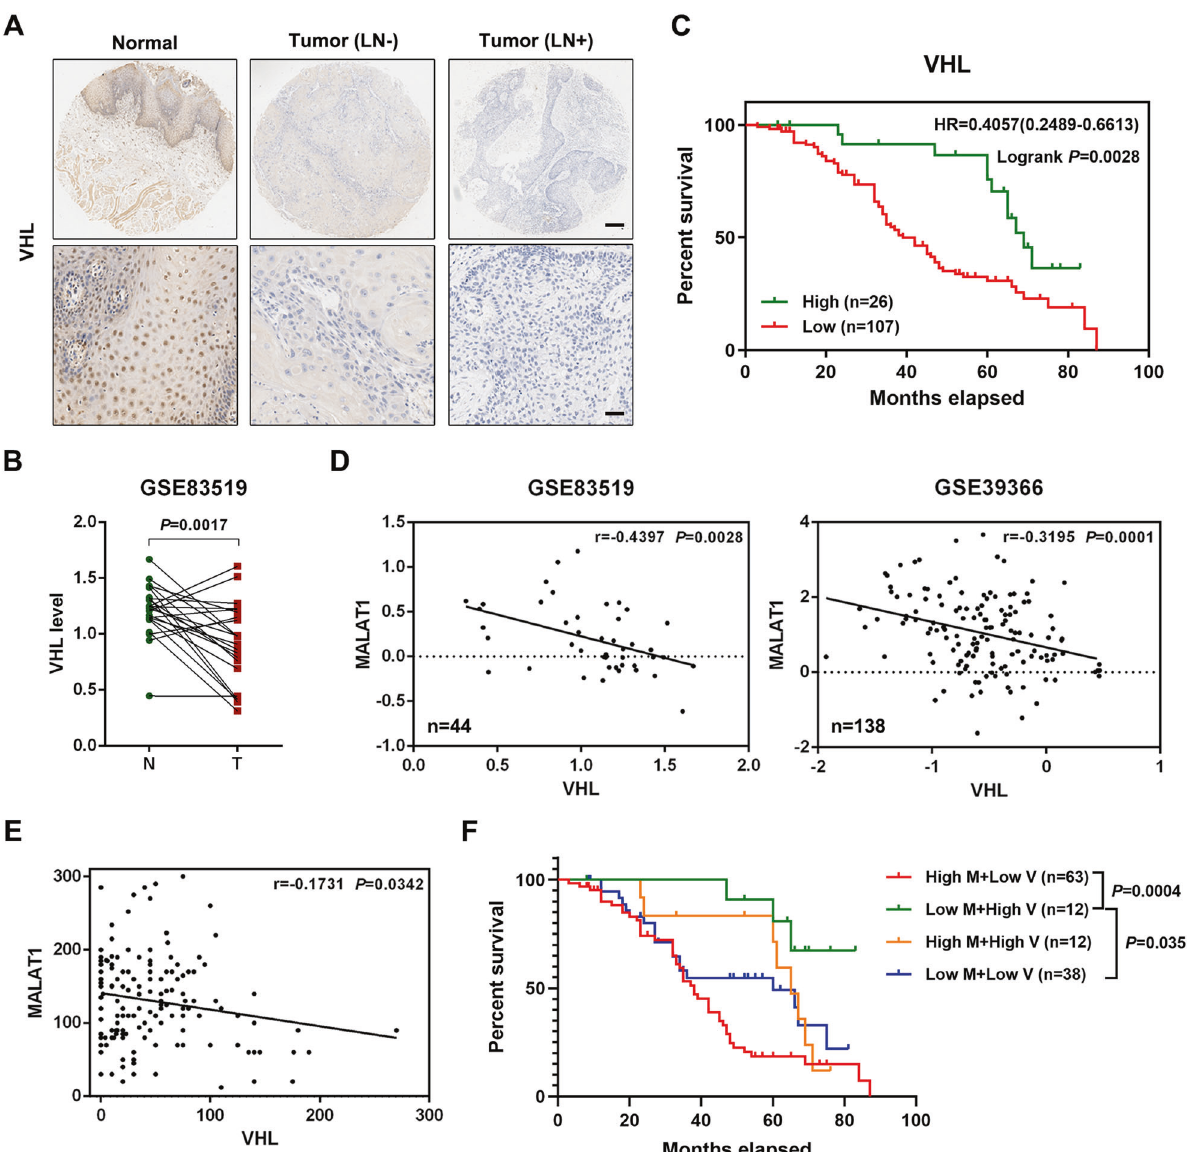
Fig. 6 VHL is downregulated in HNSCC tissues and negatively correlates with MALAT1. A Representative IHC images of VHL in HNSCC specimens (with/without lymph node metastasis) and adjacent normal tissues. Scale bar, 250 μ m (upper) and 25 μ m (lower). LN − , without lymph node metastasis. LN + , with lymph node metastasis. B The bioinformatic analysis of GSE83519 databset showed that the level of VHL in normal tissues was signi fi cantly higher than that in HNSCC tissues. Data, mean±SD. T tumor tissues. N normal tissues. C Kaplan – Meier plot determined that decreased VHL suggested unfavorable HNSCC outcome in our cohort (HR = 1.769, P = 0.0006). D The expression correlation between MALAT1 and VHL was analyzed based on the data of two GEO databases (GSE83519 and GSE39366). E The analysis of ISH and IHC staining indicated that MALAT1 expression negatively correlated with the level of VHL in our HNSCC cohort. F Detailed Kaplan – Meier plot was conducted according to the level of both MALAT1 and VHL in our HNSCC cohort. The results showed that high MALAT1 expression/low VHL expression predicted shorter overall survival of patients with HNSCC. High M high MALAT1 expression. Low M low MALAT1 expression. High V high VHL expression. Low V low VHL (Fig. 7C). Moreover, targeting MALAT1 strikingly impeded the MALAT1 depletion using a mouse model of lymph node lymph node metastasis of xenografts on the basis of H&E metastasis. Until the SCC15 cells were xenografted into the staining in inguinal lymph node (Fig. 7D, E). Subsequently, the instep for 14 days, the mice were treated with negative control in vivo siMALAT1 dramatically reduced the level of MALAT1 in oligos or in vivo siRNAs targeting MALAT1. As shown in Fig. 7A, xenografts (Supplementary Fig. 15), and IHC staining showed compared with the control group, MALAT1 siRNAs signi fi cantly that si-MALAT1 obviously reduced EZH2, p-STAT3, p-Akt inhibited the tumor growth of xenografts, while no difference expression, and elevated VHL level in SCC15 xenografts (Fig. was observed in the body weight between two groups. Then, 7F). Taken together, these results suggest that MALAT1 could we collected the xenografts and inguinal lymph nodes (Fig. 7B) be served as a promising target to inhibit HNSCC growth and and found that the tumor weight of xenografts treated with lymph node metastasis. MALAT1 siRNAs was much lighter than that of negative control